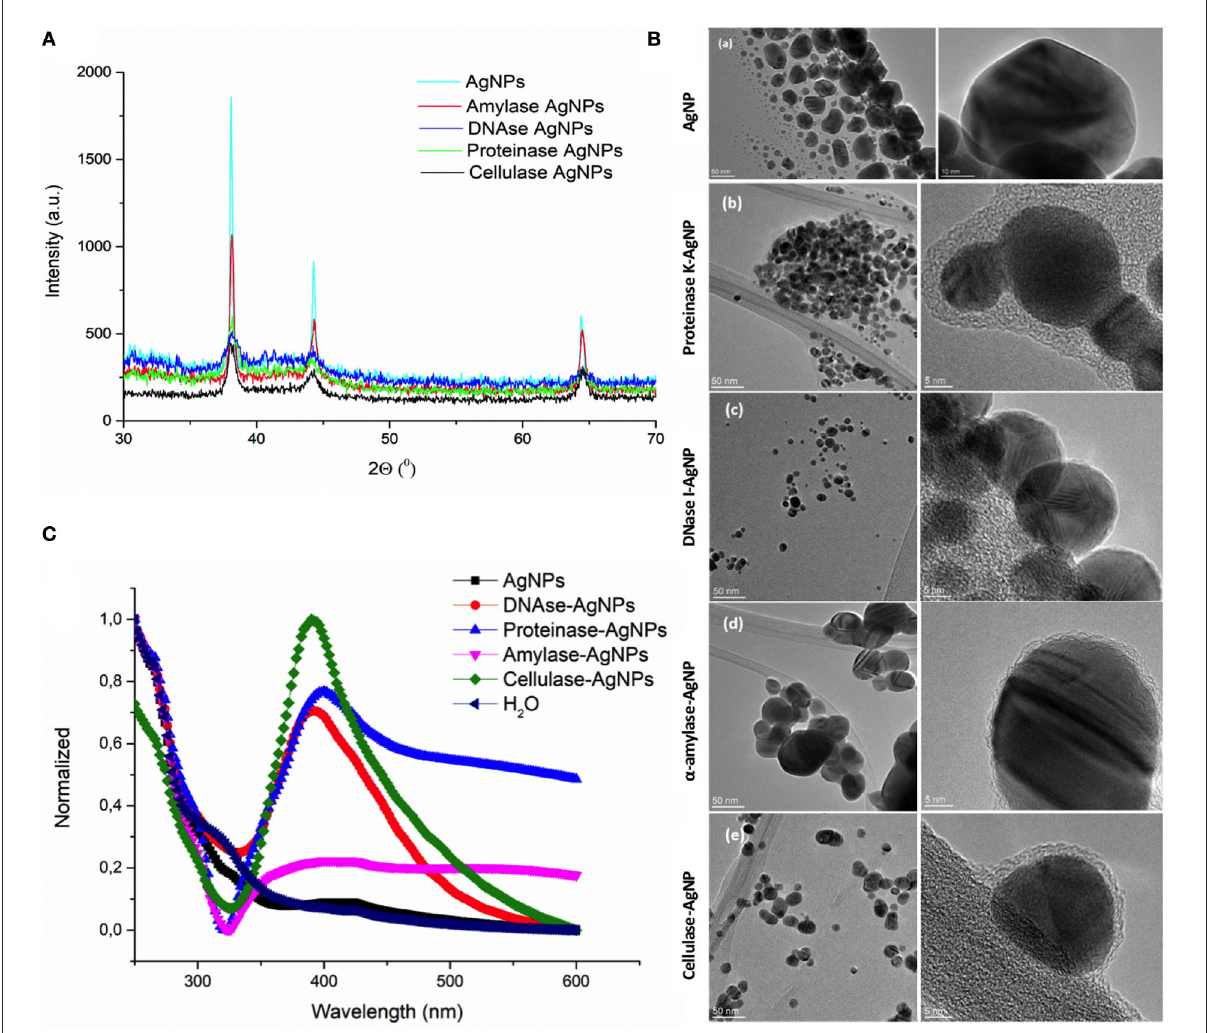
FIGURE2 Characterization of silver nanoparticles (AgNP). (A) X-ray diffraction patterns of bare AgNP and AgNP with immobilized α -amylase, DNase I, proteinase K, and cellulase. (B) TEM images of AgNP with different surfaces: bare AgNP without enzyme (a), AgNP with proteinase K (b), DNase I (c), α -amylase (d), and cellulase (e). Images on the left present particle size and agglomeration, while those on the right look closely at the organic coating immobilized on their surface. (C) UV-vis spectra showing the stability of AgNP without and with different enzymes (DNase I, α -amylase, cellulase, and proteinase K) immobilized to their surface based on the presence or absence of surface plasmon resonance maximum (SPR), its position, and width.